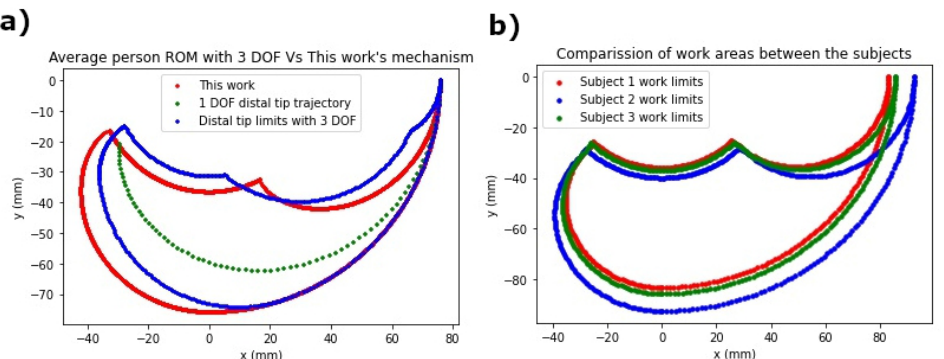
Figure 7. ( a ) Work area comparison between subjects. ( b ) Average work area with 3 DOF vs. work area of this mechanism using an index finger of 73